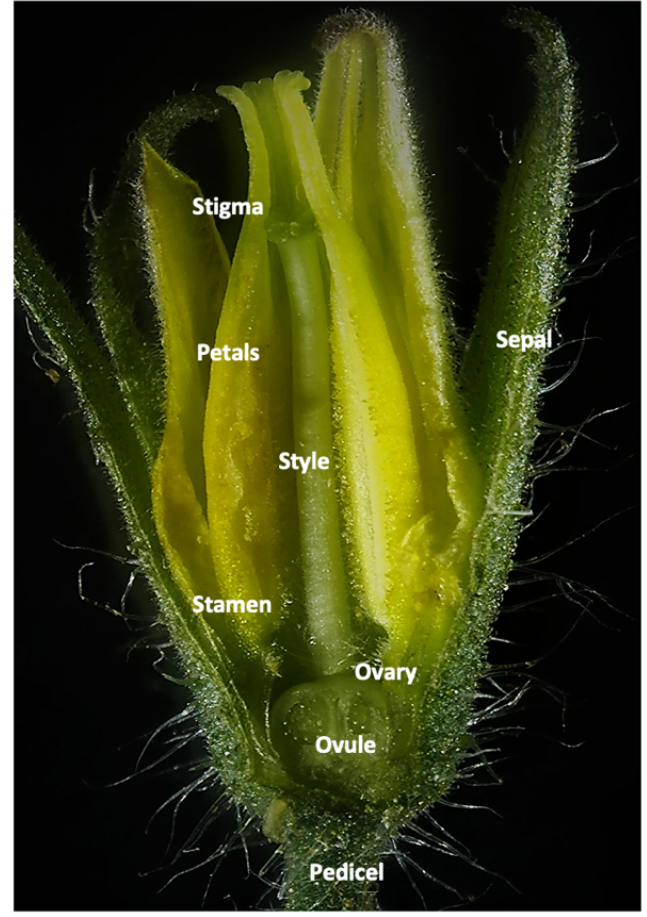
Figure 1. Structure and organs of a tomato flower.